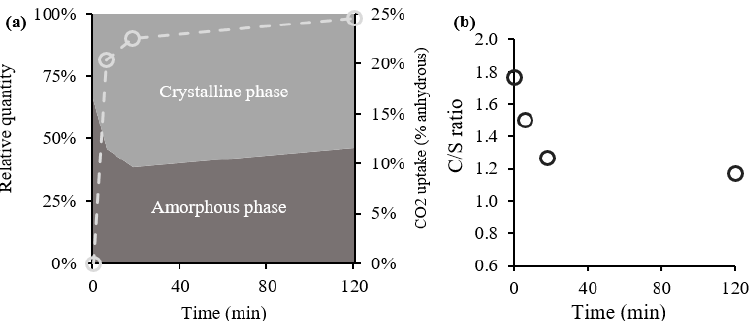
Figure 7. Comparison of amorphous and crystalline phases with the CO 2 uptake in the dashed curve ( a ) and C/S ratio of C-S-H ( b ). C/S ratio computed from Equation (3).